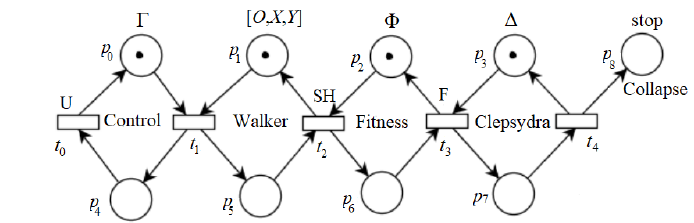
Figure 17. Quantum individual